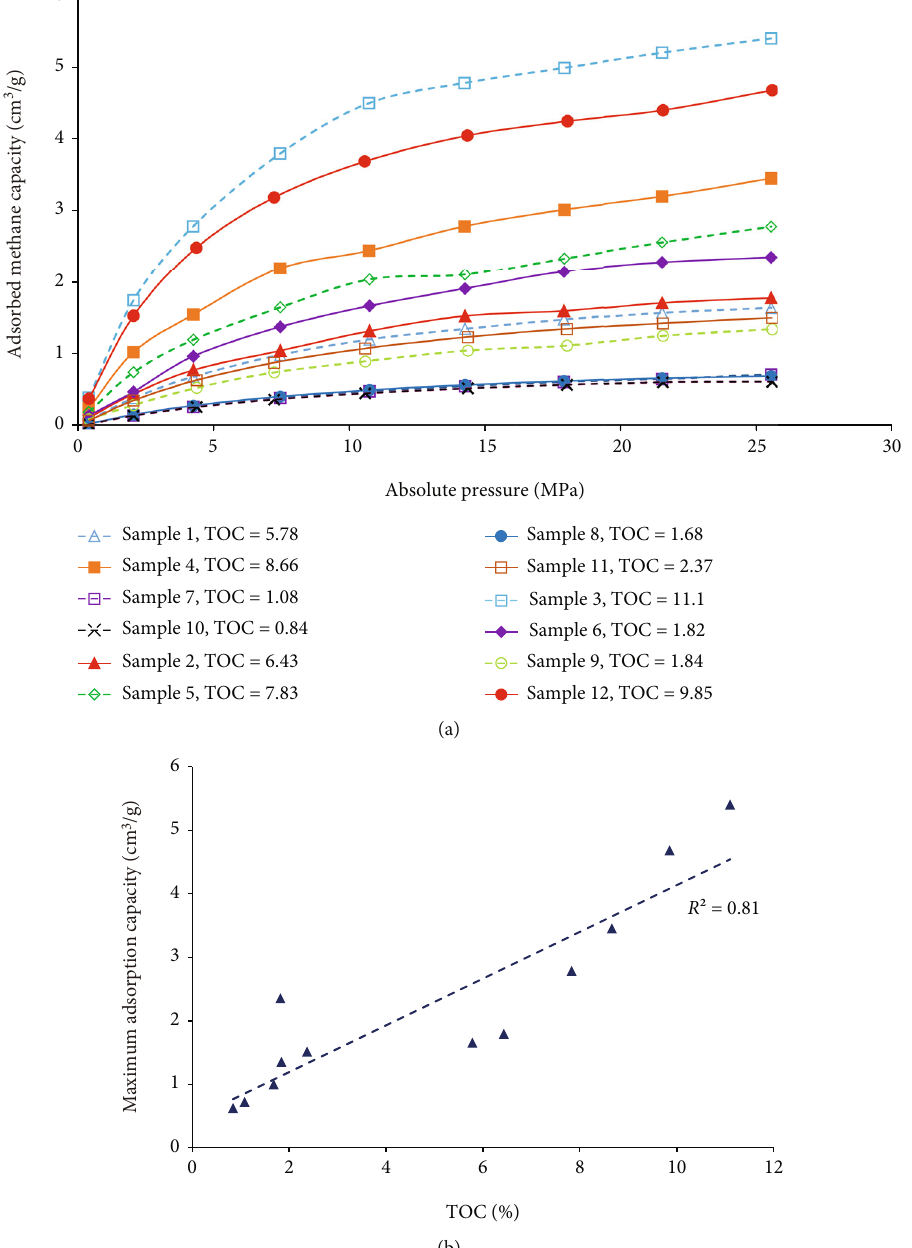
Figure 5: (a) Isothermal adsorption curves of shale samples and (b) the interrelationship between TOC content and maximum adsorption